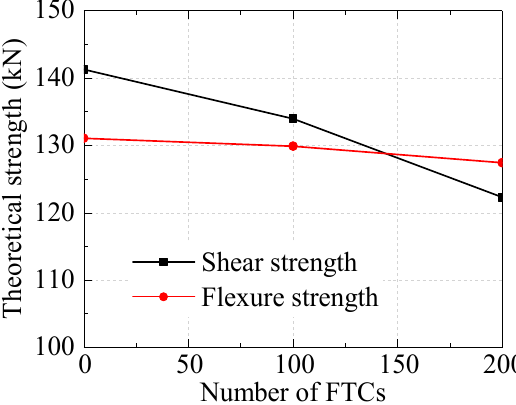
Figure 10. Theoretical strength of specimens under different numbers of FTCs.